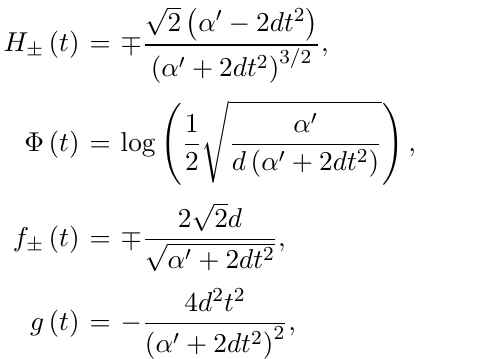
Figure 2 . The left panel shows the non-perturbative Hubble parameters. Blue solid line describes H + ( t ) and red dashed line denotes H (cid:0) ( t ). The right panel shows the O ( d; d ) dilaton evolution along the time. We set d = 3, (cid:11) 0 = 1 and n = 1 in these plots. n = 1 and the solutions